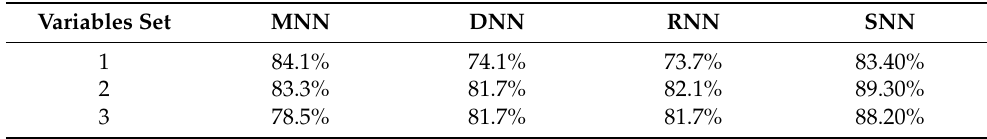
Table 8. Accuracy of the used models for training data.